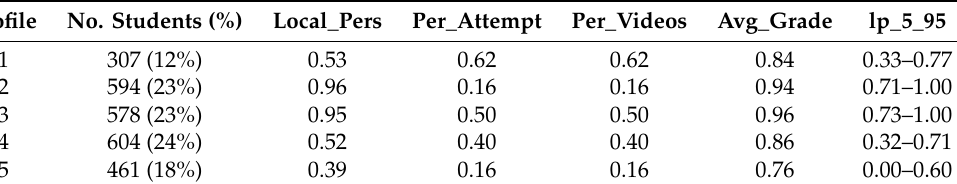
Table 4. Students’ profiles based on their local persistence and interactions with videos / exercises.